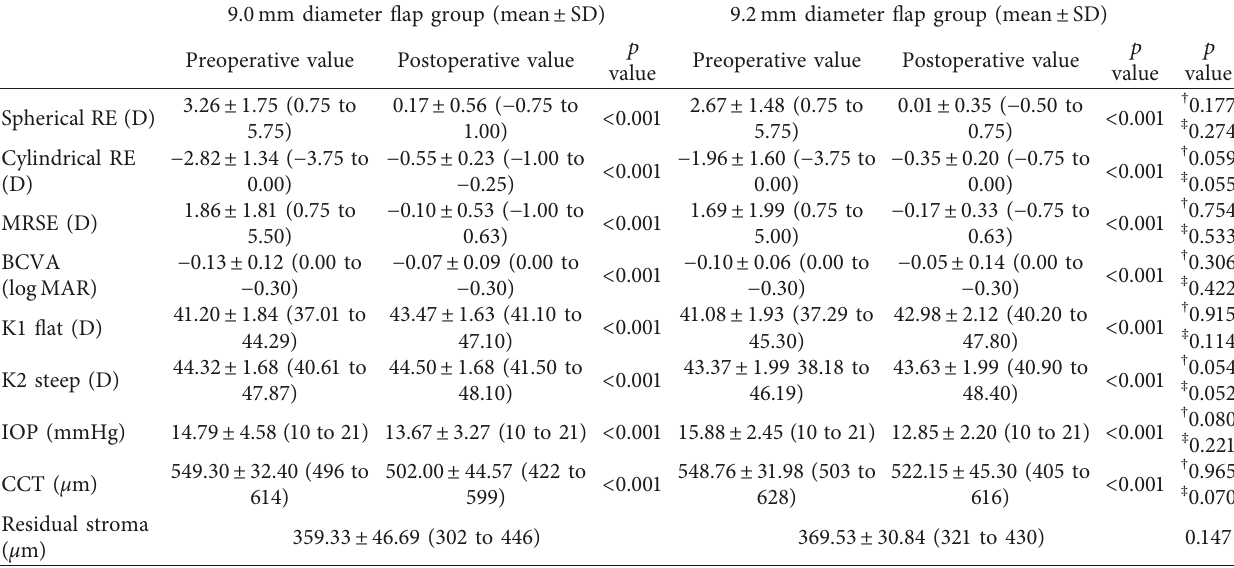
Table 1: The comparison of demographic and clinical characteristics of the 9.0 ( n � 34) and 9.2 ( n � 34) mm diameter flap groups.